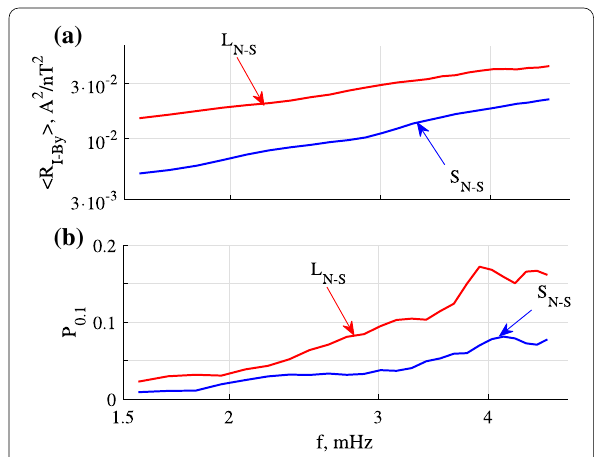
Fig. 11 a Averaged R I − By spectra for the N–S large- ( L NS ) and small-scale ( S NS ) pulsations. ( L NS = L γ L ϕ L P in Figure 10, while all the other groups form the S NS group) ; b frequency dependence of R I − By > 0.1 A 2 /nT 2 fraction for the same groups of